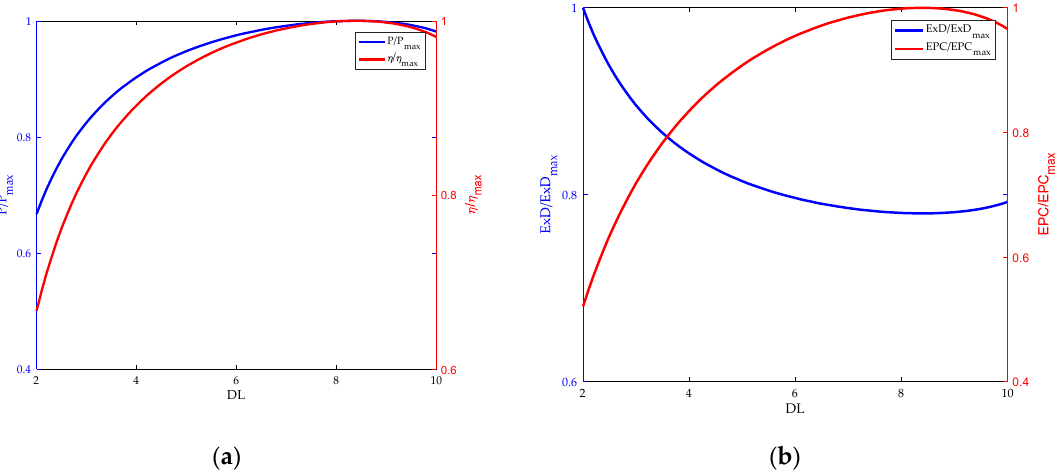
Figure 6. Influence of doping level. ( a ) Power density and energy efficiency; ( b ) exergy destruction rate and exergetic performance coefficient.